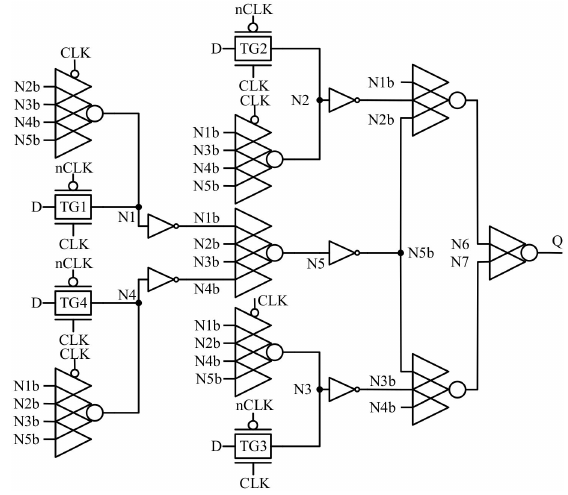
Figure 6. Schematic of TNUHL latch.